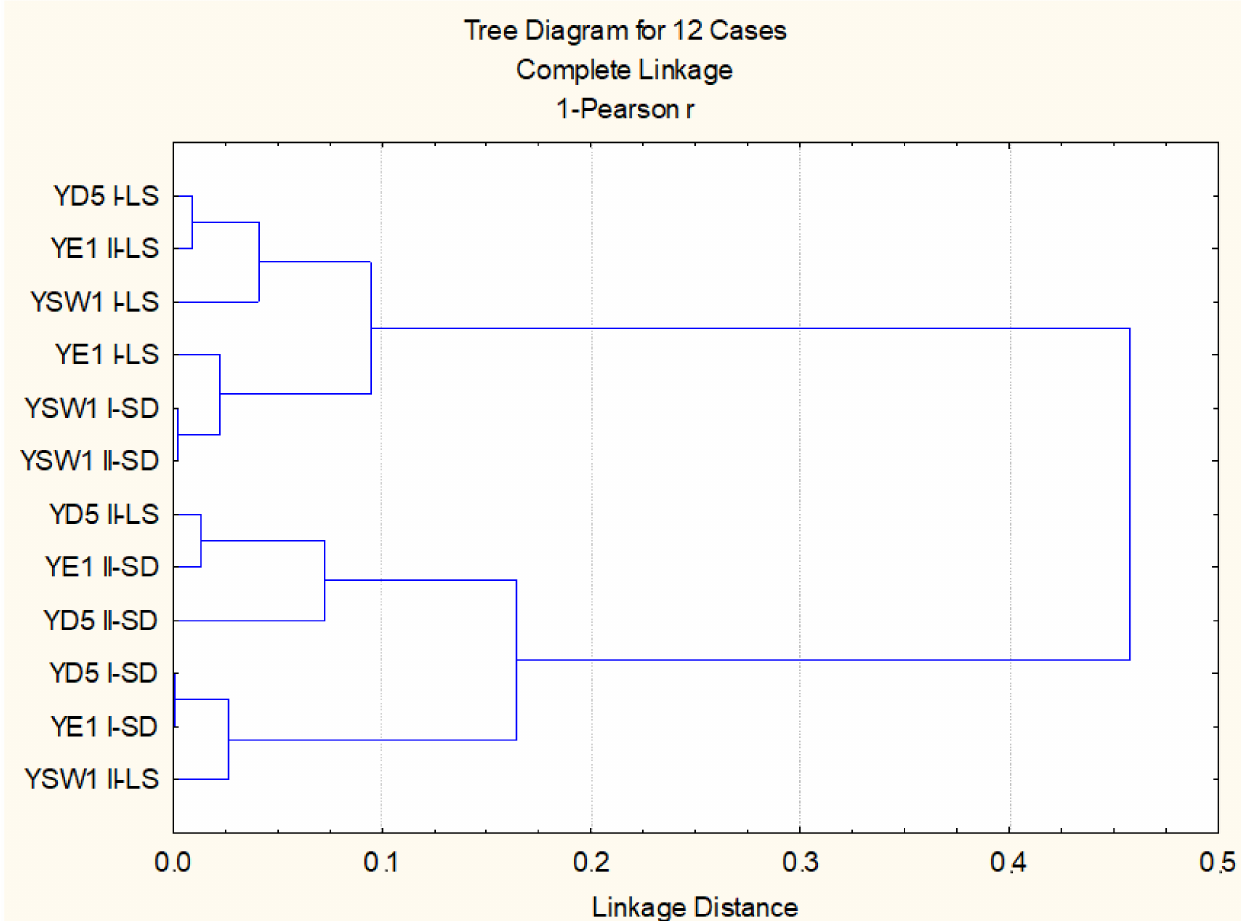
Figure 3. Cluster analysis on the base of all studied biometric and physiological